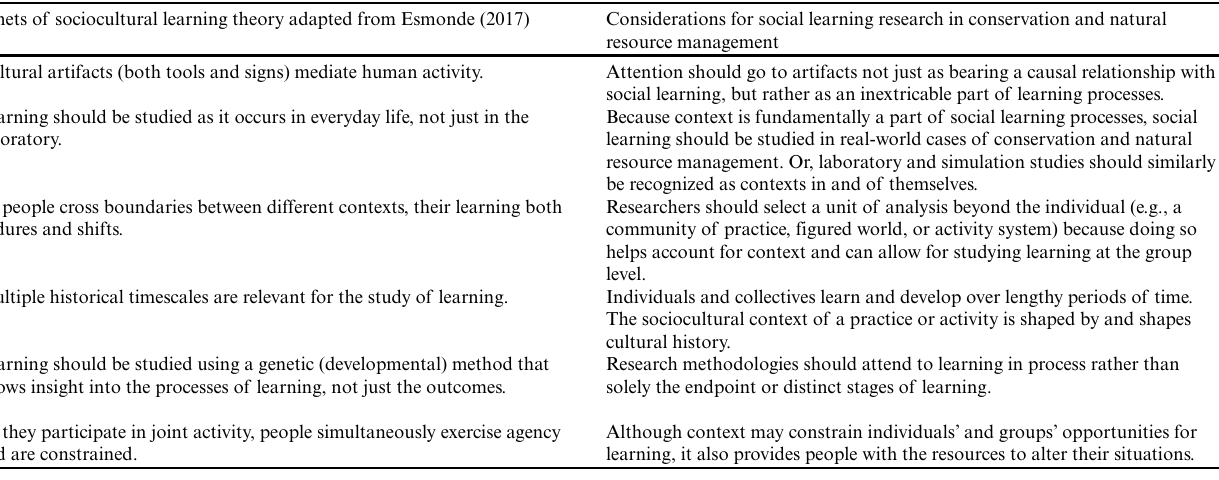
resource management